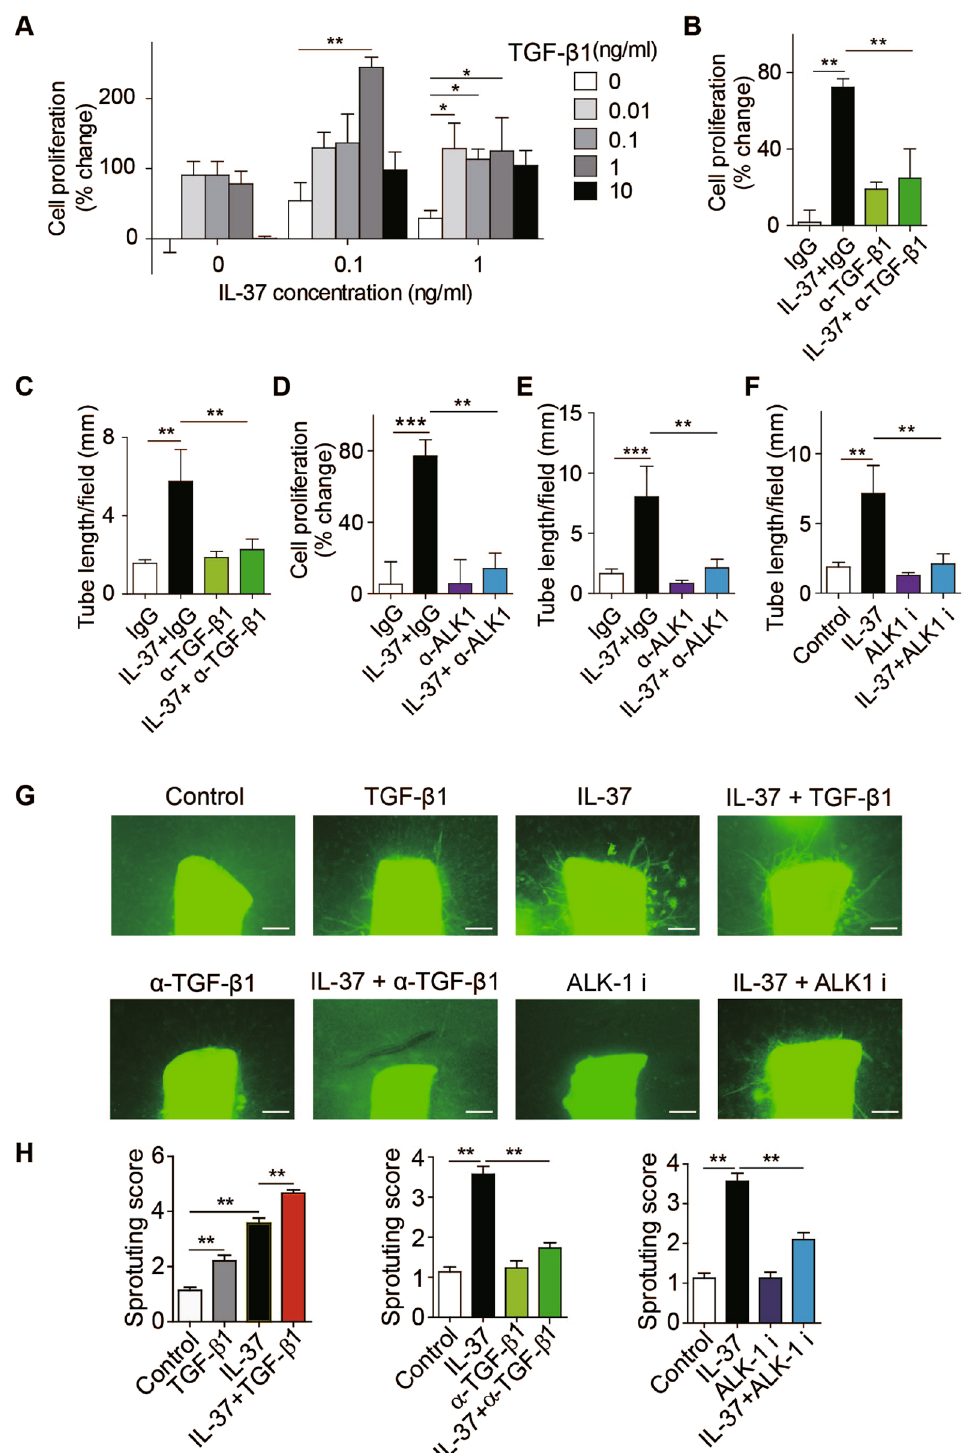
Figure 4. IL-37 promotes angiogenesis via TGF- β signaling pathway. ( A ) TGF- β 1 augmented IL-37-induced cell proliferation in a dose-dependent manner. ( B and C ) TGF- β -neutralizing antibodies ( α -TGF- β 1, 10 μ g/mL) suppressed IL-37 (1 ng/mL) induced ( B ) HUVEC proliferation (n = 5 per group) and ( C ) tube formation (n = 5 per group). ( D and E ) ALK1-neutralizing antibodies ( α -ALK1) blocked IL-37 (1 ng/mL) induced ( D ) HUVEC proliferation (n = 6) and ( E ) tube formation (n = 6). ( F ) ALK1 inhibitor (ALK i) LDN193189 (0.5 μ M) inhibited IL-37-stimulated Matrigel tube formation. n = 5 per group. ( G ) Blockade of TGF- β 1 or ALK1 with neutralizing antibodies (10 μ g/mL) or inhibitor (0.5 μ M) inhibited IL-37 (1 ng/mL) stimulated vessel growth from aortic rings. n = 10 per group. ( H ) Aggregate analysis of the sprouting. n = 10 per group. Data are presented as mean ± SEM. * P < 0.05, ** P < 0.01 and *** P <